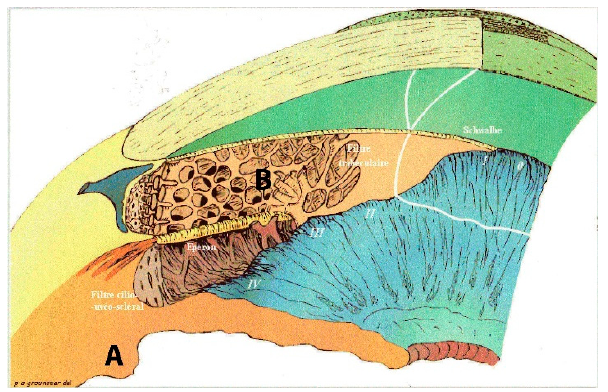
Figure 1. Goniogram 3D inner eye aqueous circuitry. A ciliary process production. B trabecular meshwork resorption impaired in hypertensive glaucoma patients and normal in normal intraocular pressure (IOP) glaucoma patients. 0 to IV: filtration corneoscleral angle degrees.